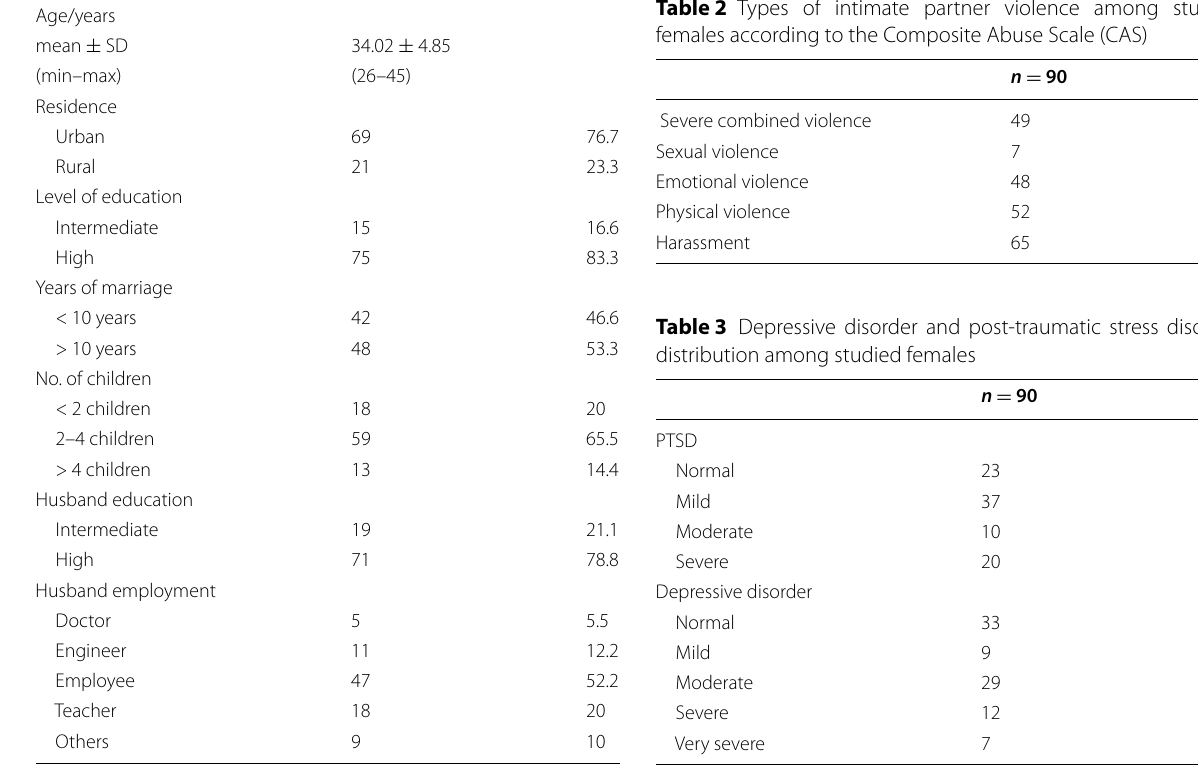
Table 3 studied post-traumatic stress disorder distri-